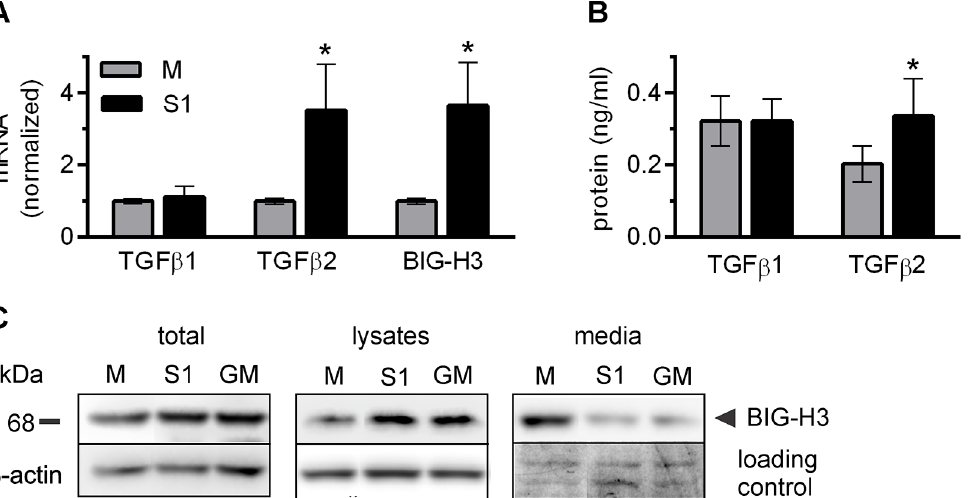
Fig 7. ADAM17 silencing increases the expression of TGF β 2 and BIG-H3 in lymphatic endothelial cells (LEC). ( A ) Quantitative RT-PCR analysis of TGF β 1, TGF β 2 and BIG-H3 mRNA levels in M and S1. Bars represent mean ± SD from five independent experiments performed in duplicates. * P < 0.01 vs M. ( B ) The levels of TGF β 1 and TGF β 2 released to the medium by M and S1 measured by ELISA. Bars represent mean ± SD from three (TGF β 1) or five (TGF β 2) independent experiments performed in duplicates. * P < 0.01 vs M. ( C ) Western blotting analysis of the levels of BIG-H3 present in lysates and media of M, S1, and M incubated for 48 h with GM6001 (GM). Total – combined lysates and media. In each lane protein sample from the same number of cells was loaded. A fragment of blot stained with Coomassie Brilliant Blue after antigen detection procedure was used as a loading control of media samples (right lower